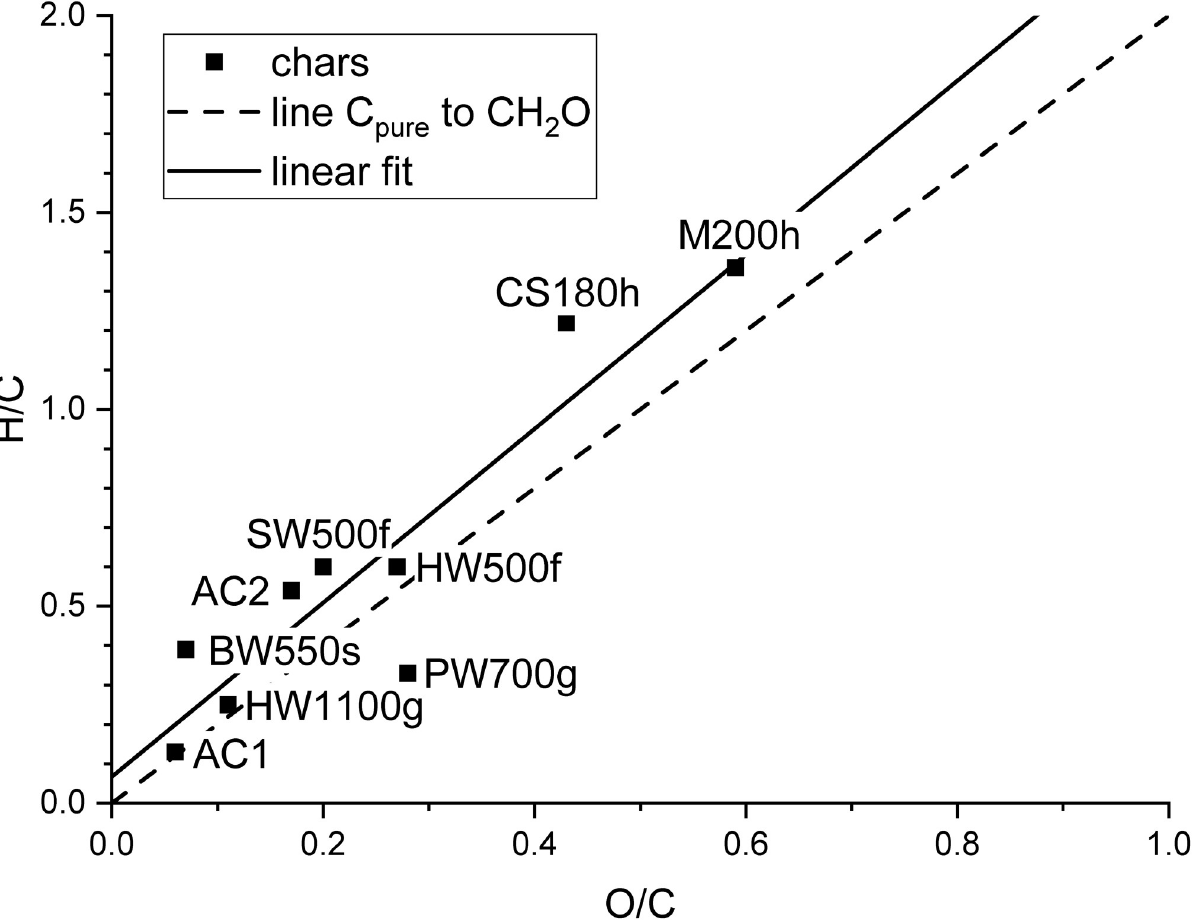
Fig 2. Van-Krevelen diagram of the investigated